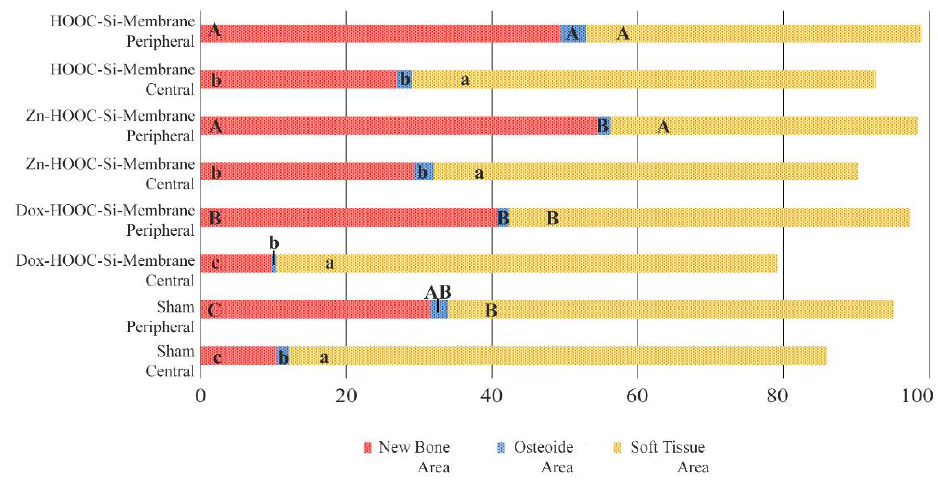
Figure 7. Histomorphometric study of the new bone area (NBA, in red), osteoid area (OA, in blue), and soft tissue area (STA, in yellow) fractions when lateral and central areas of the defect were compared. Same letters within each color indicate no significant differences. Statistical significance is indicated with capital letters for differences among peripheral regions of the distinct membranes and with lower-case letters for differences among central regions of the distinct membranes.